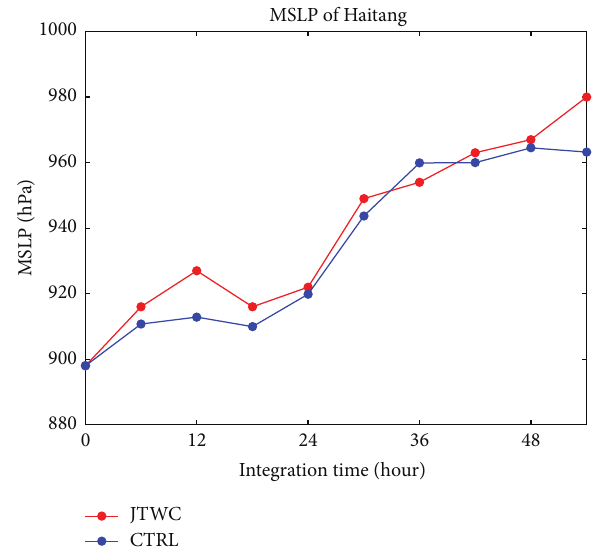
Figure 2: Time series of the minimum sea level pressure (MSLP, units of hPa) from the 6-hourly JTWC best track analysis (red) and CTRL simulation (blue) during the period of 0000 UTC 17 July to 0600 UTC 19 July